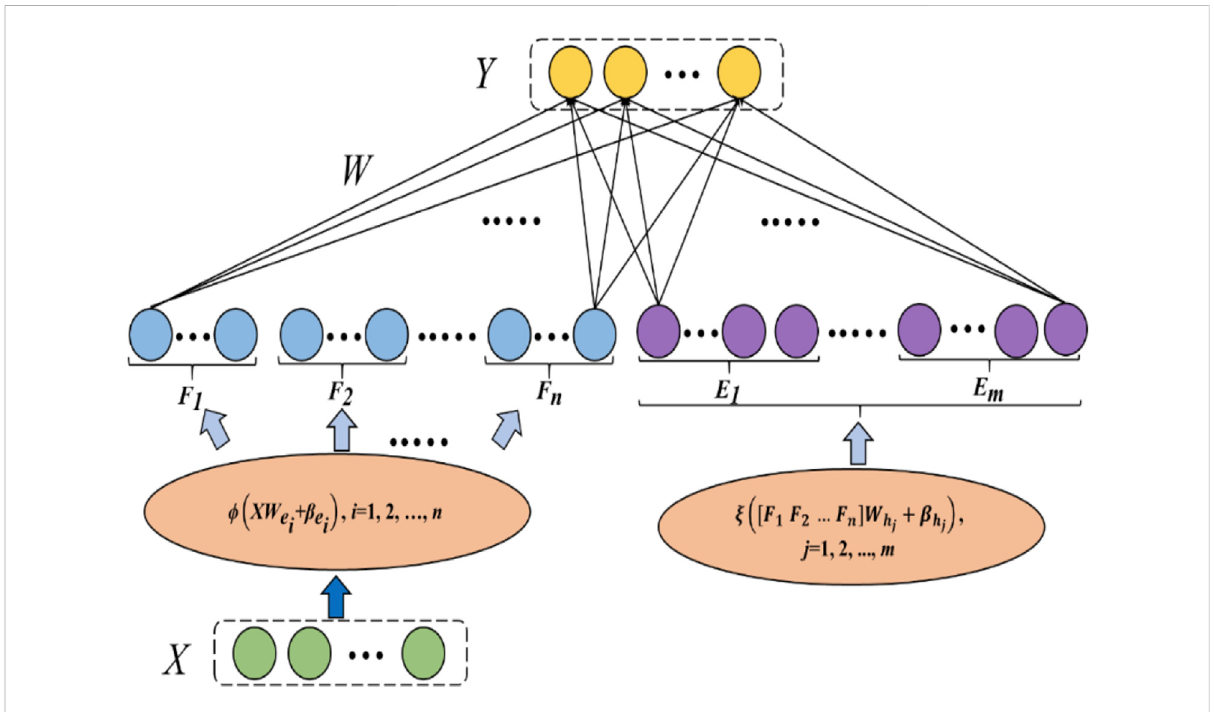
FIGURE 5 The framework of the BLS